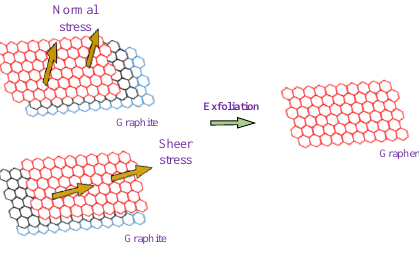
Figure 1. Mechanism of stripping method.